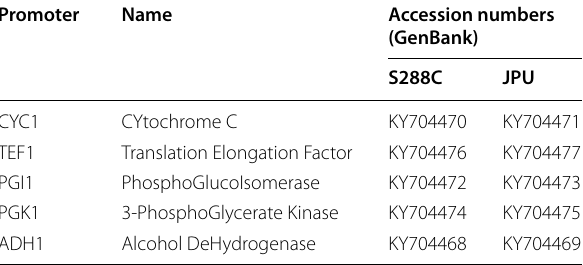
Table 2 Promoters used in plasmids constructions